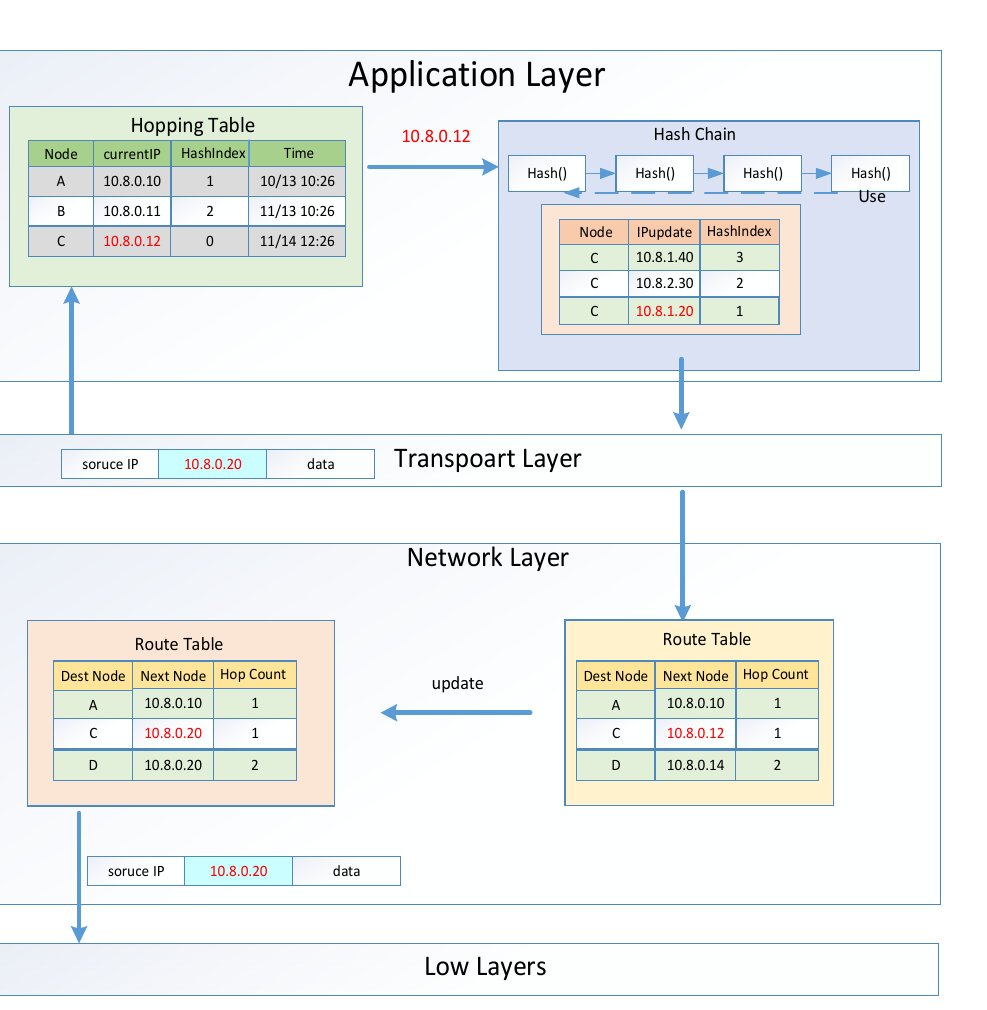
Figure 5. Device IP address hop diagram.